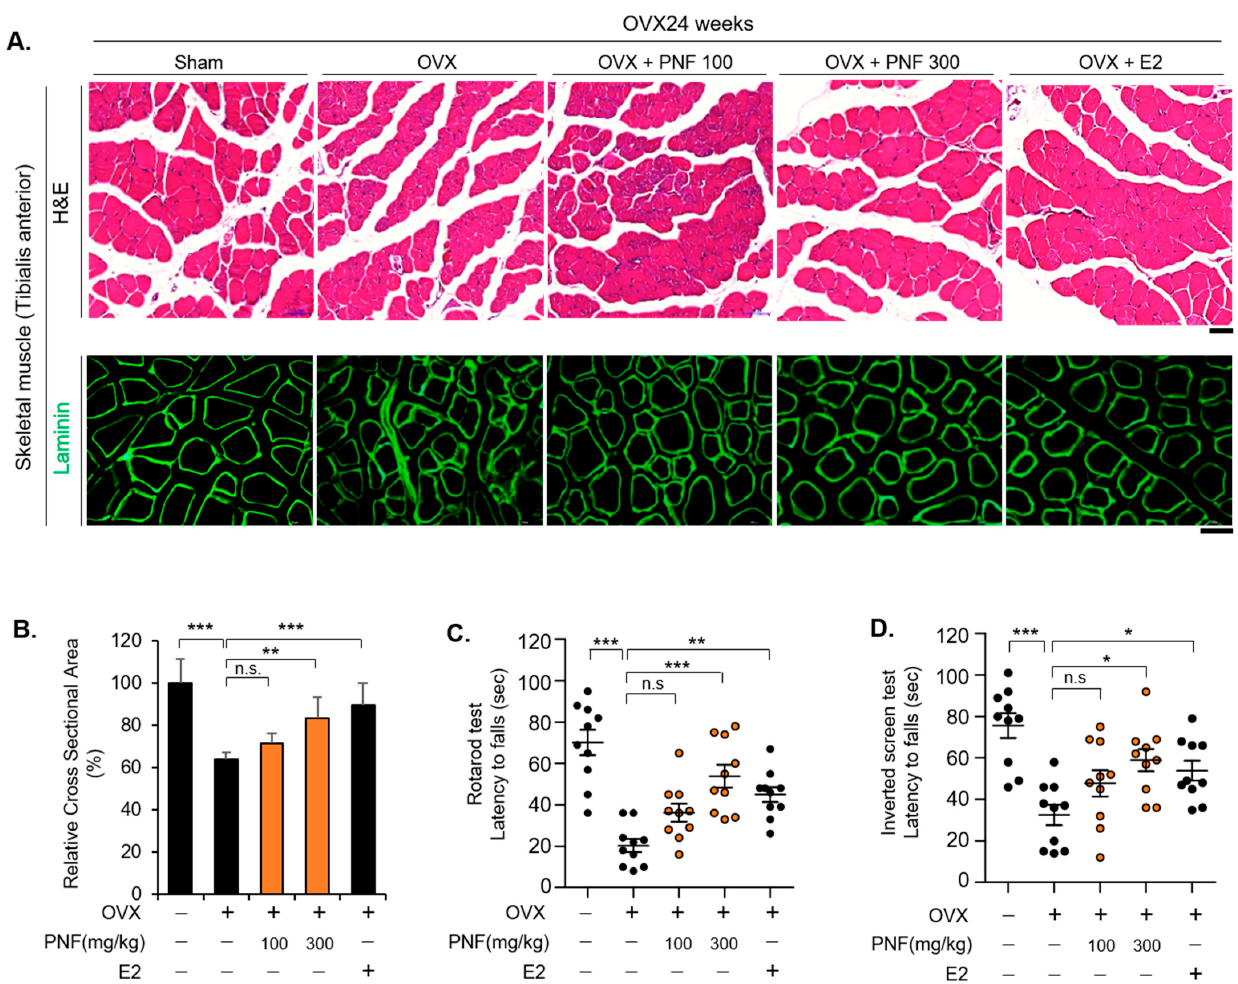
Figure 4. Decreased CSA rescued by PNF in TA muscle of OVX mice: ( A ) Representative hematoxylin and eosin (H&E) and laminin immunofluorescence staining of TA muscle sections. PNF was tested at 100 and 300 mg/kg/day on OVX mice. E2 was used a positive control. Morphology of representative sections visualized using H&E staining. The laminin sections were used for the measurement of fiber area. n = 10 for each group. Magnification × 40, Scale bar, 50 µ m. ( B ) CSA values were quantified in individual fibers. n = 100 for each group. ( C ) Rotarod test of sham and OVX mice administered PNF and E2. n = 10. ( D ) Inverted screen test results for sham and OVX mice administered PNF and E2. n = 10. * p < 0.05, ** p < 0.01, and *** p < 0.001. N.S., not significant.